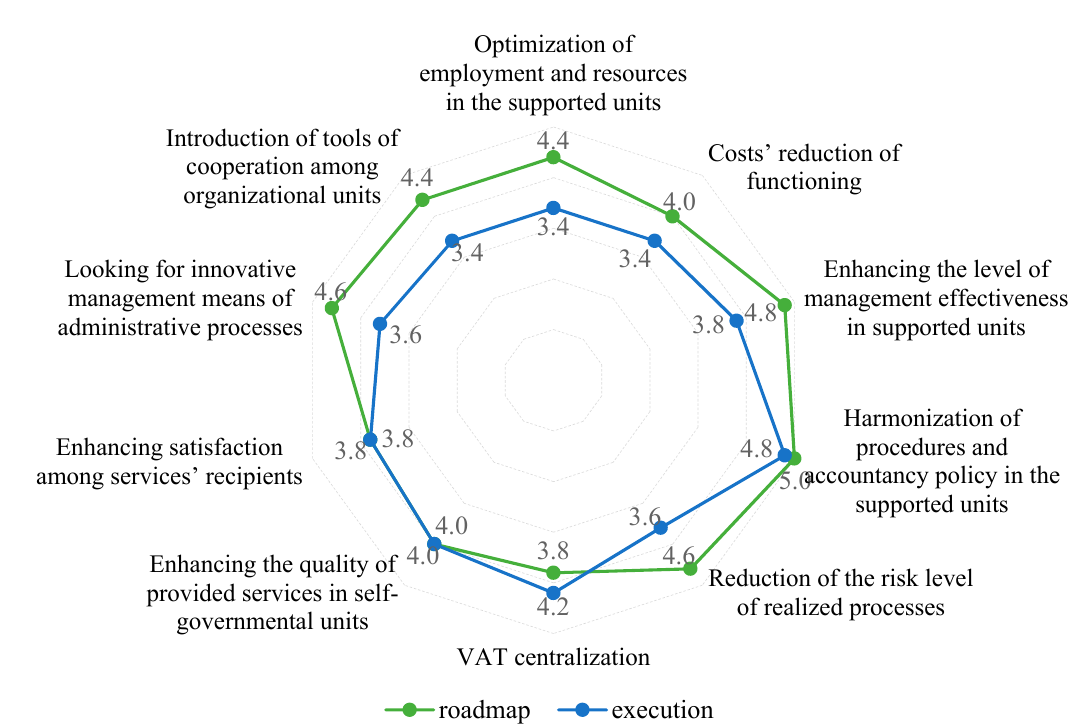
Figure 3. Main objectives in the process of establishing shared service centers (SSCs) (supported unit treasurer evaluation—a roadmap and its execution). Source: Modrzy´nski, P., Gawłowski, R., Modrzy´nska, J. (2019). Local Shared Service Centres. Analysis of functioning and evaluation of provided service effectiveness , https://www.portalsamorzadowy.pl/pliki-